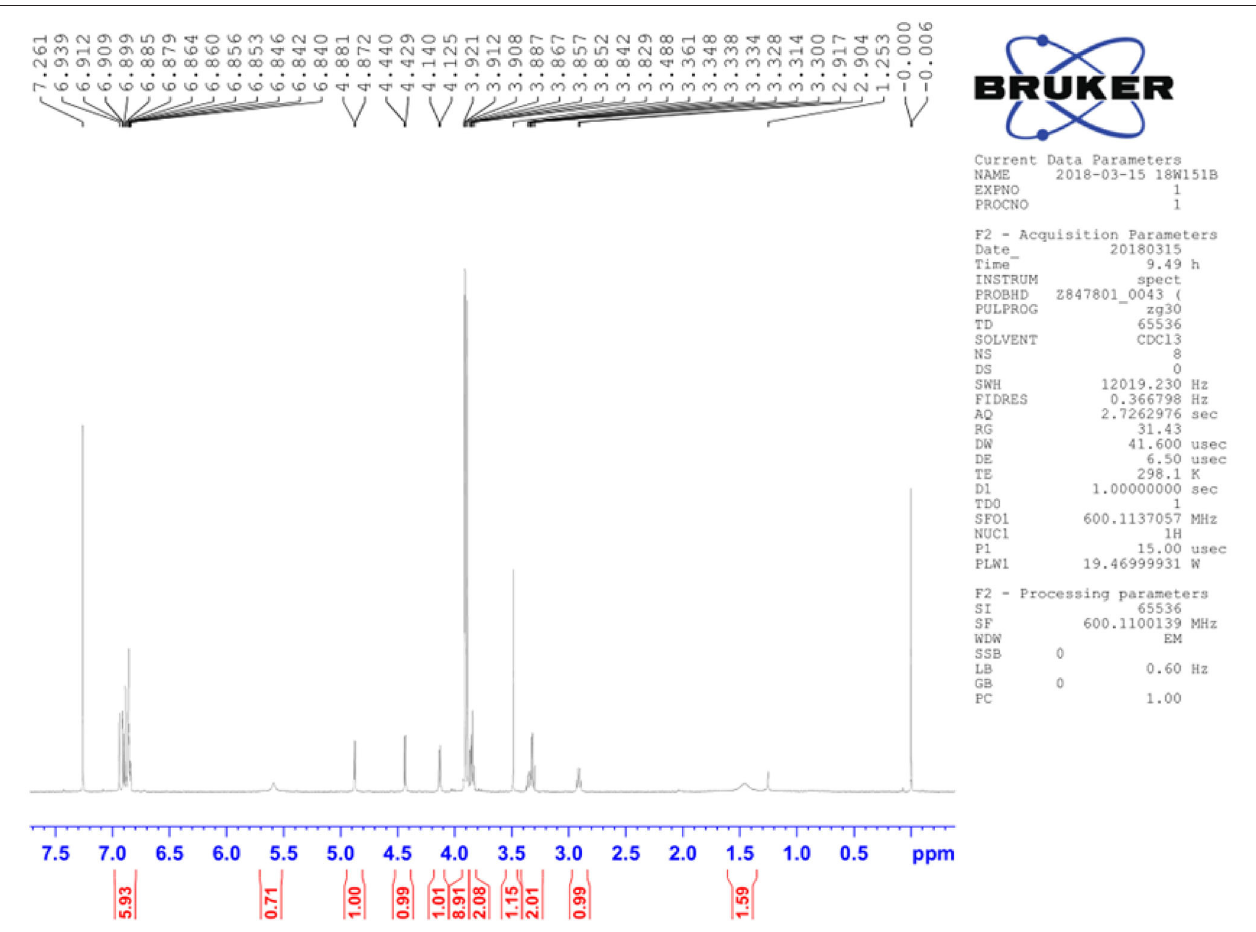
FIGURE 1 | Liquid chromatogram of